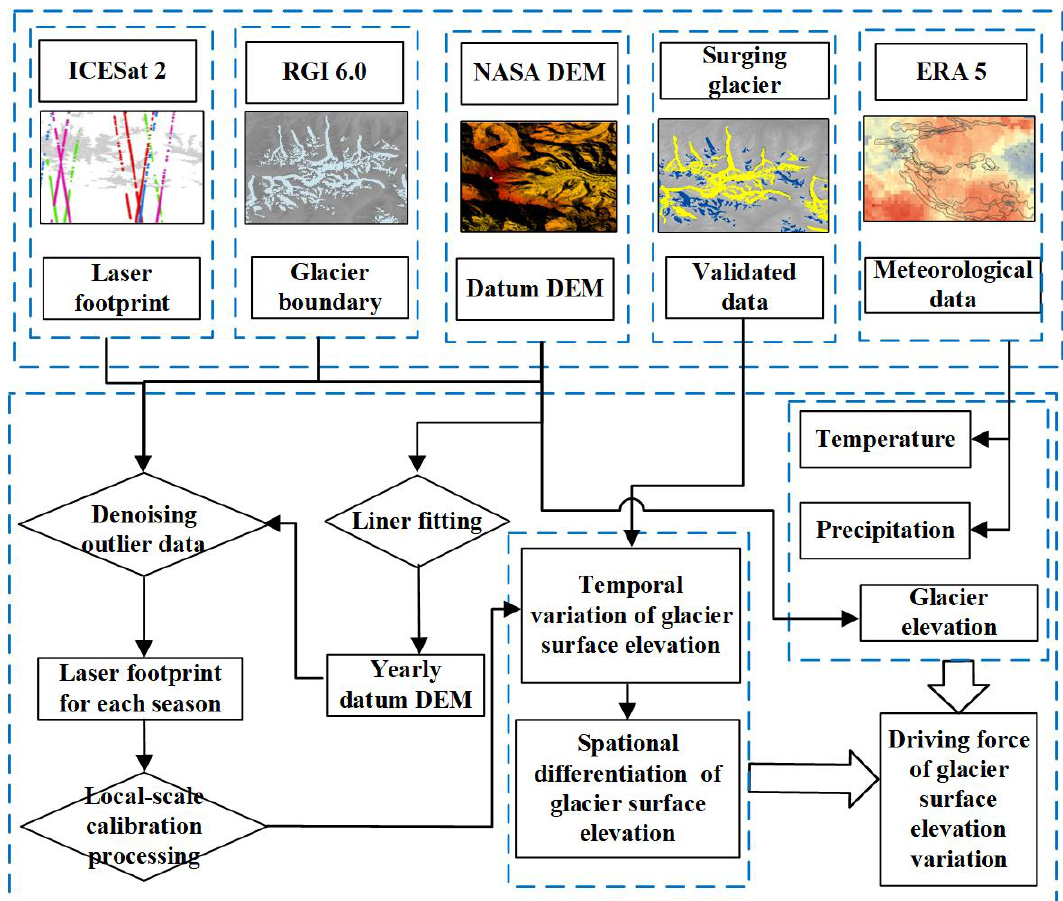
Figure 4. Flowchart of the methodology followed to measure the glacier surface elevation variations from the ICESat 2 laser footprints and the driving forces analysis.